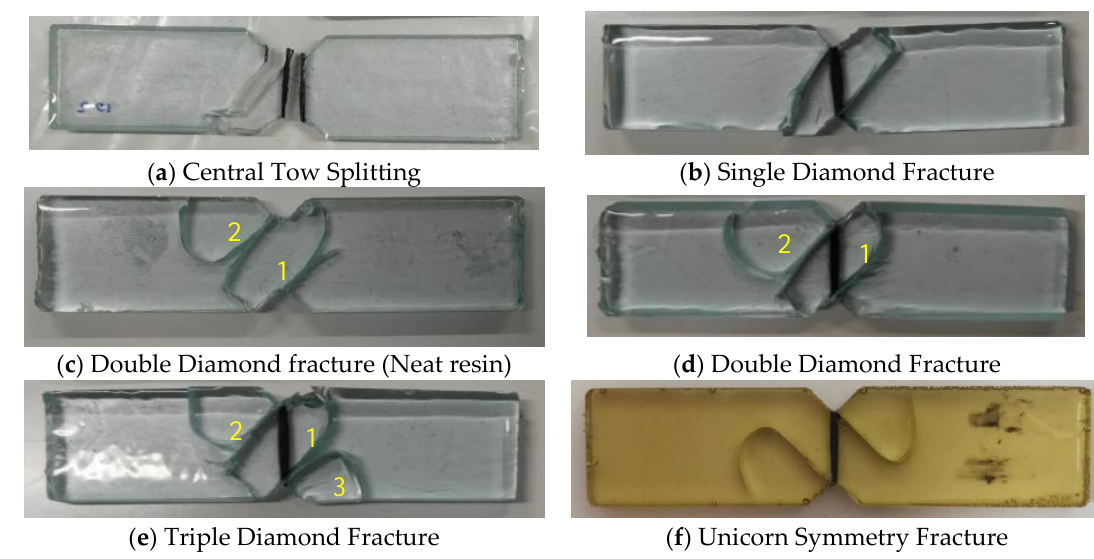
Figure 7. Catalogue of commonly observed fracture patterns during Iosipescu tow testing ( a – f ).